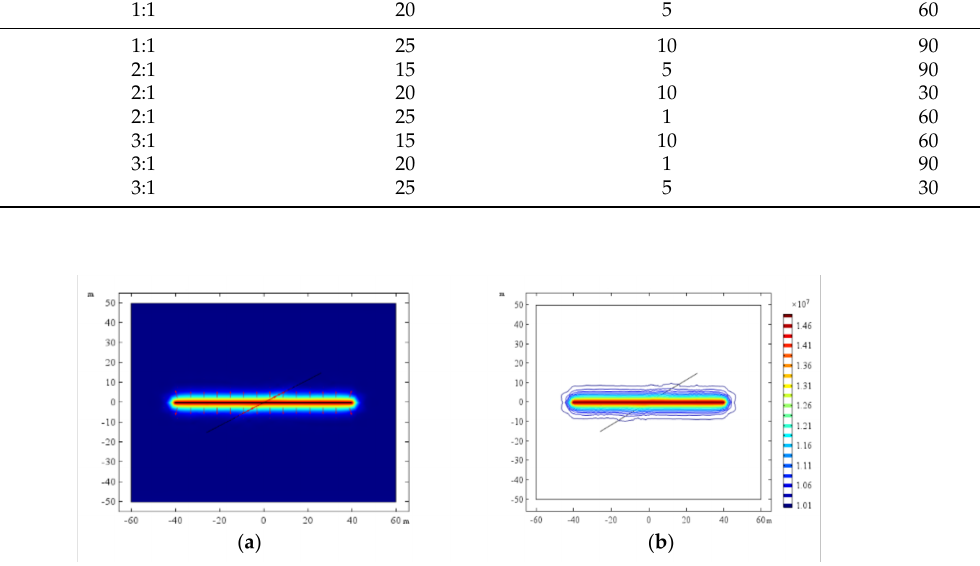
Figure 4. Case 1 calculation result. ( a ) Grout propagation pattern. ( b ) Distribution of grout propaga- tion pressure